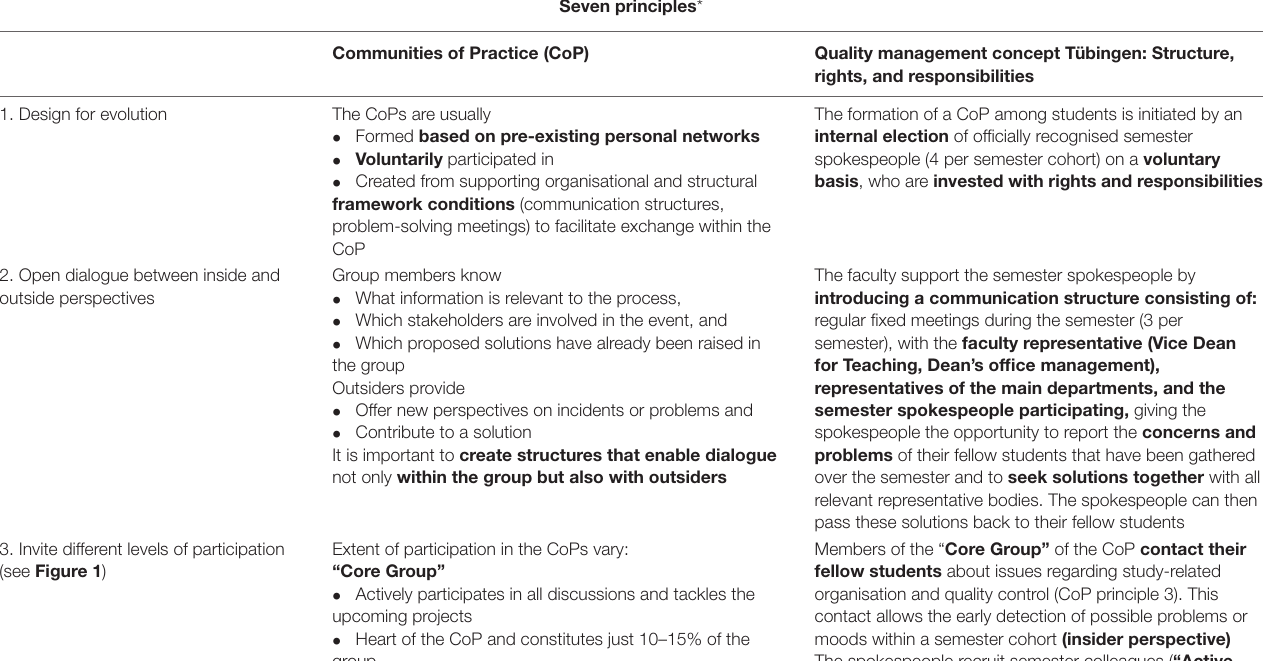
TABLE 1 | Comparison of the seven principles of Communities of Practice with the participatory quality management at Medical Faculty